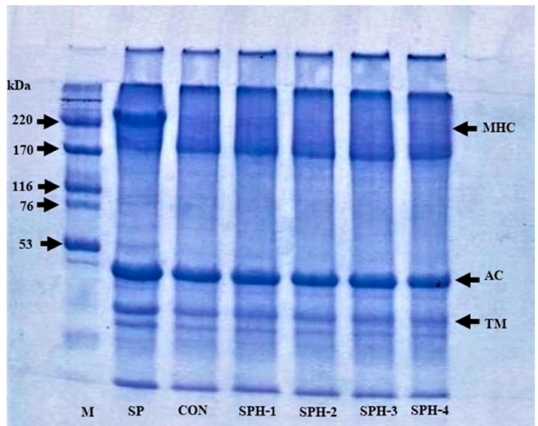
Figure 2. Protein patterns of threadfin bream surimi paste and gel without and with psyllium husk at different levels. M: high molecular weight marker, SP: surimi paste, MHC: myosin heavy chain, AC: actin, and TM: tropomyosin. Caption: See Figure